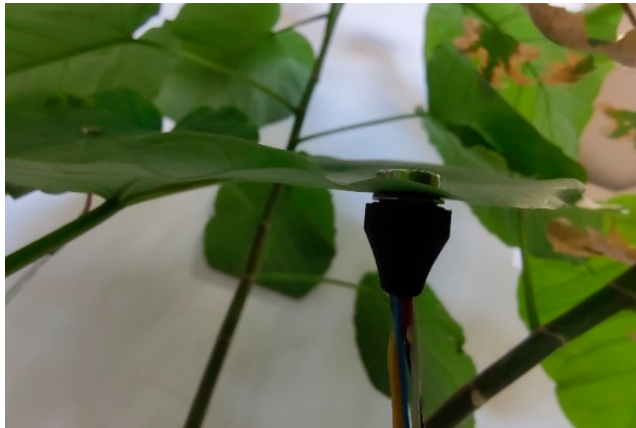
Figure 7. Measurement chart of swelling pressure probe.